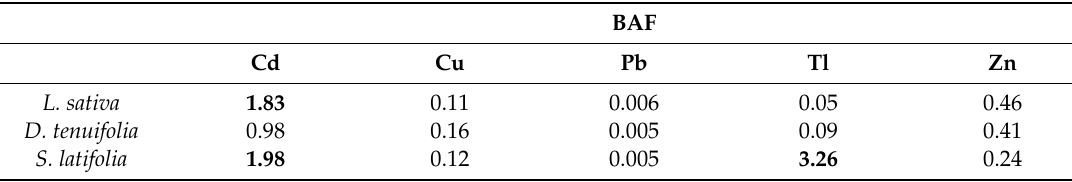
Table 5. Bioaccumulation factor (BAF) of each PTE in shoots of L. sativa , D. tenuifolia and S. latifolia (three harvests weighted